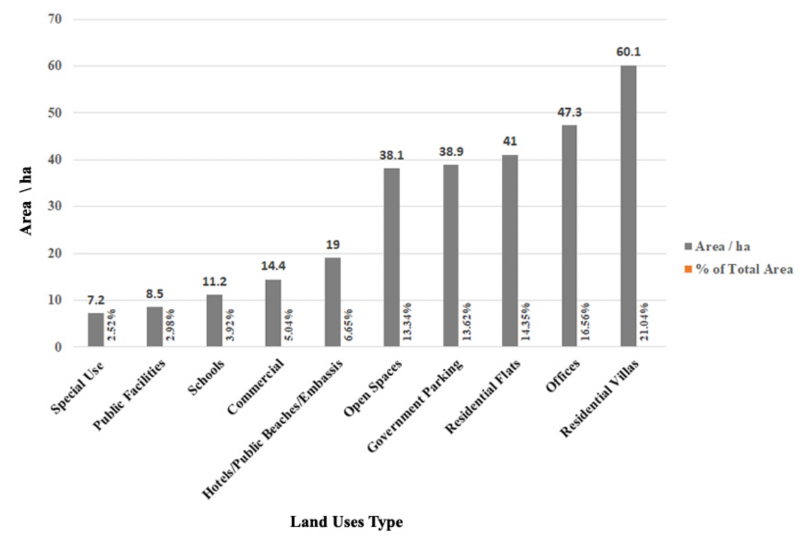
Figure 9. Land uses distribution area and its percentage within the DCA of the DECC metro station. 3.